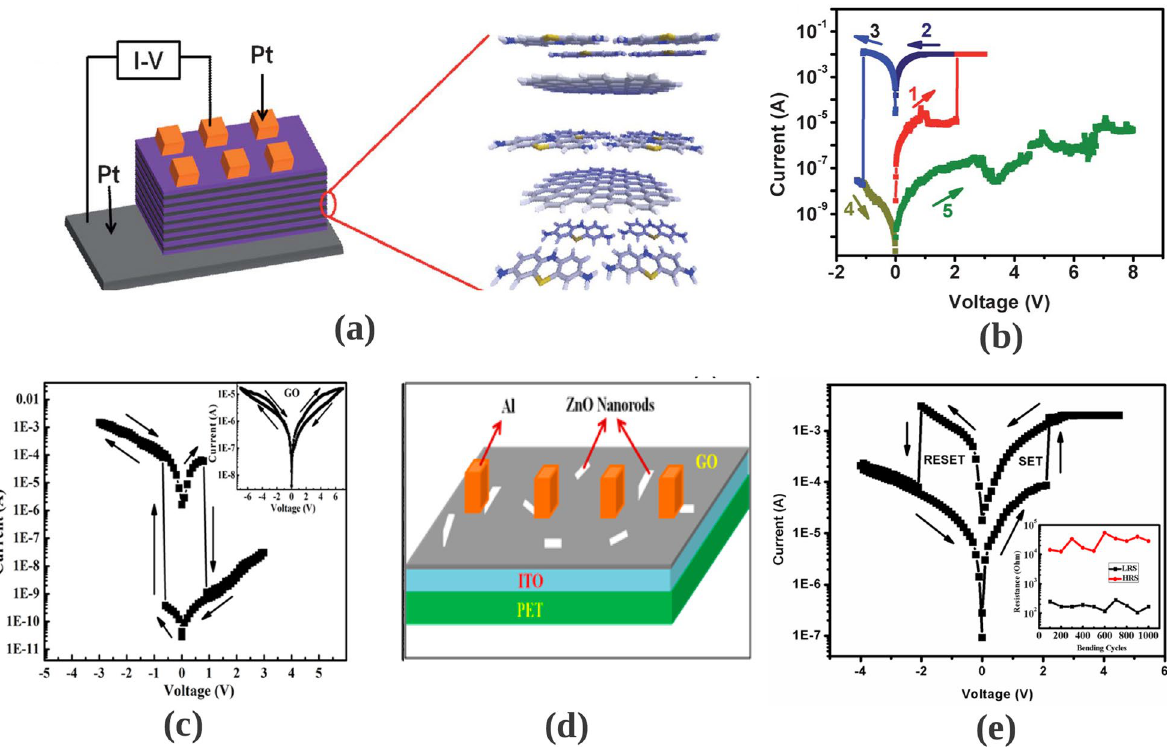
Fig. 21 Graphene oxide 2D-based material. a , b Sketch and I–V characteristics of the Pt/rGO-th/Pt device, respectively [257]. c I–V charac- teristics of the Al/GOAu/ITO and Al/GO/ITO devices [262]. d Schematic orientation of Al/GOZNs/ITOPET device. e I–V characteristics and mechanical bending endurance of Al/GOZNs/ITOPET device [261]. The insets show various graphene oxide-based RRAM devices and their